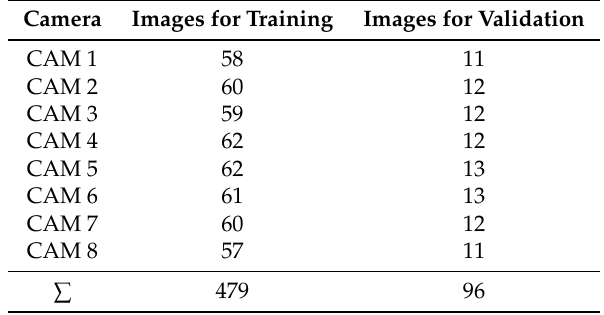
Table 1. Number of images used for training and validation data set for all eight